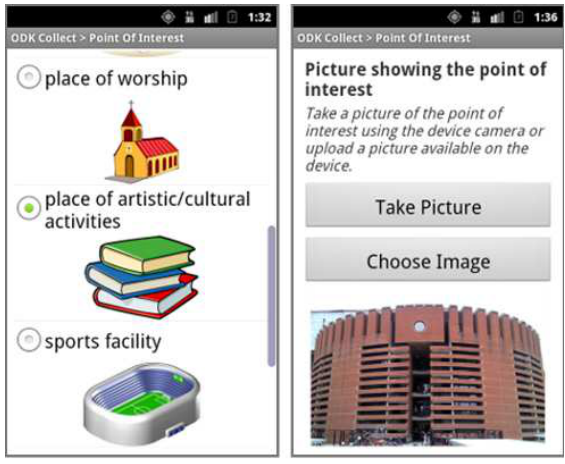
Figure 2. Screenshots of the ODK Collect application for reporting POIs, showing the choice of the POI category (left) and the POI picture taken with the device camera